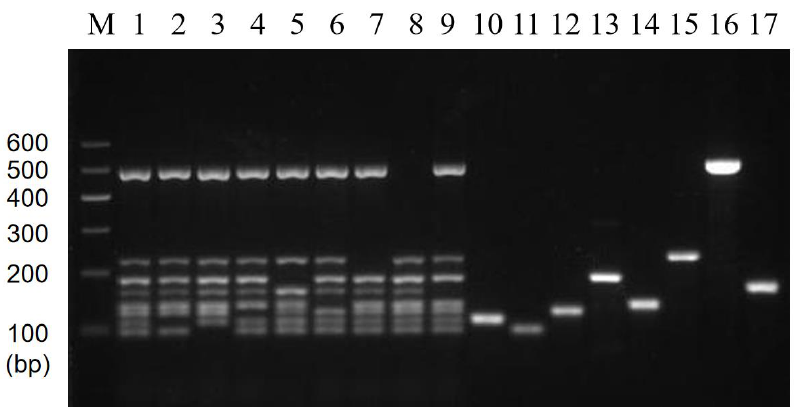
Figure 7. Results of multiplex PCR stability. Lane M: DNA marker B 600; Lane 1: Mixed 8 target DNA as templates; Lane 2~9: 8 mixed templates based on 7 templates missing E. coli O157:H7, V. parahaemolyticus , V. alginolyticus , C. sakazakii , S. flexneri , V. vulnificus , P. putida , and L. monocytogenes , respectively; Lane 10~17: Single DNA templates E. coli O157:H7, V. parahaemolyticus , V. alginolyticus